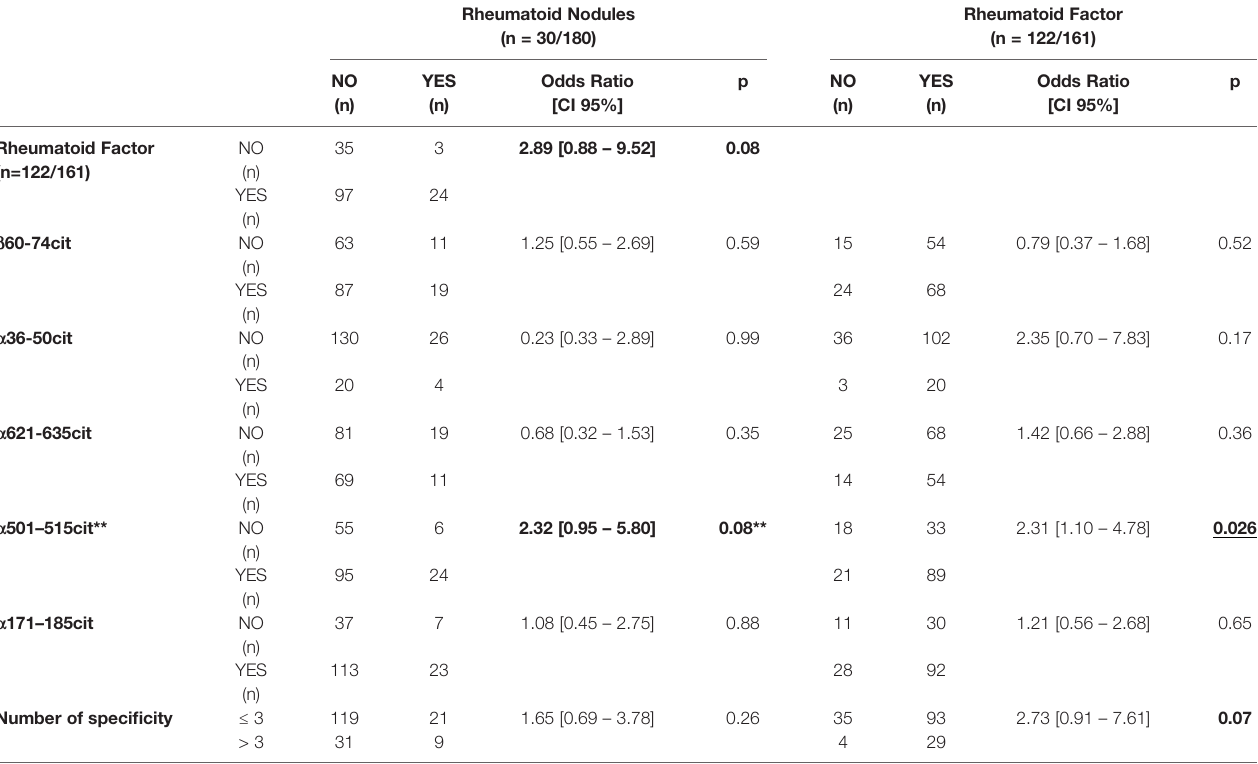
TABLE 4 | Rheumatoid nodules and Rheumatoid factor association with peptide reactivity.